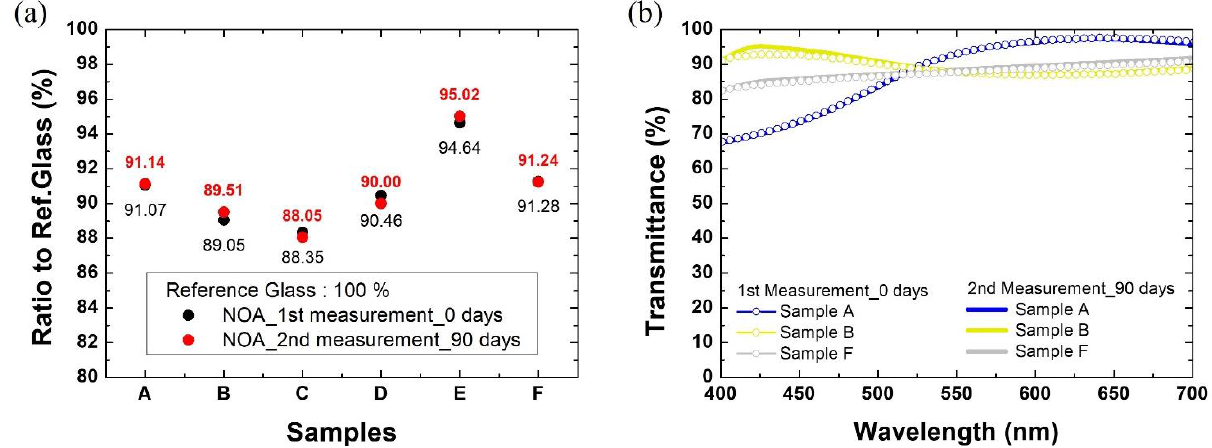
Figure 7. Characteristics and stability evaluation results of BIPV modules manufactured by colored glass A–F ( a ) power generation efficiency, ( b ) transmittance.